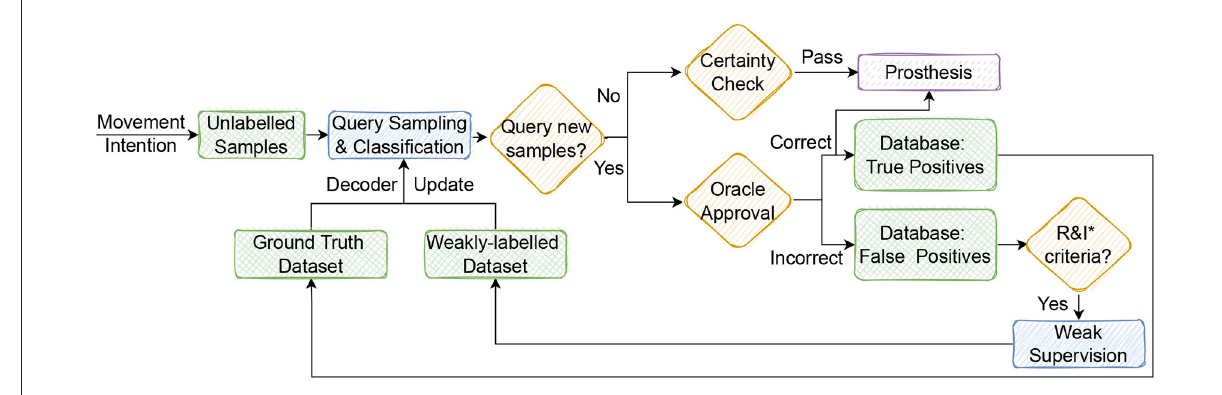
FIGURE6 The envisaged real-time operation of a user-in-the loop setting with an active learning. Movement intention generates new signal data each second (w.r.t. the sampling rate). Unlabeled samples after being preprocessed are classified by pre-trained decoder. Active learner using query sampling criteria decides whether to request the label or not. Confident samples pass certainty check criteria to be sent to the prosthesis actuator. If a sample is queried by the active learner, the oracle dis-/approves the decoder prediction. Incorrect predictions are filtered with R&I (representativeness and informativeness criteria) for outlier detection and interesting samples to be weakly-labeled. These combined with ground truth samples are used to update the decoder. *R&I, representativeness and